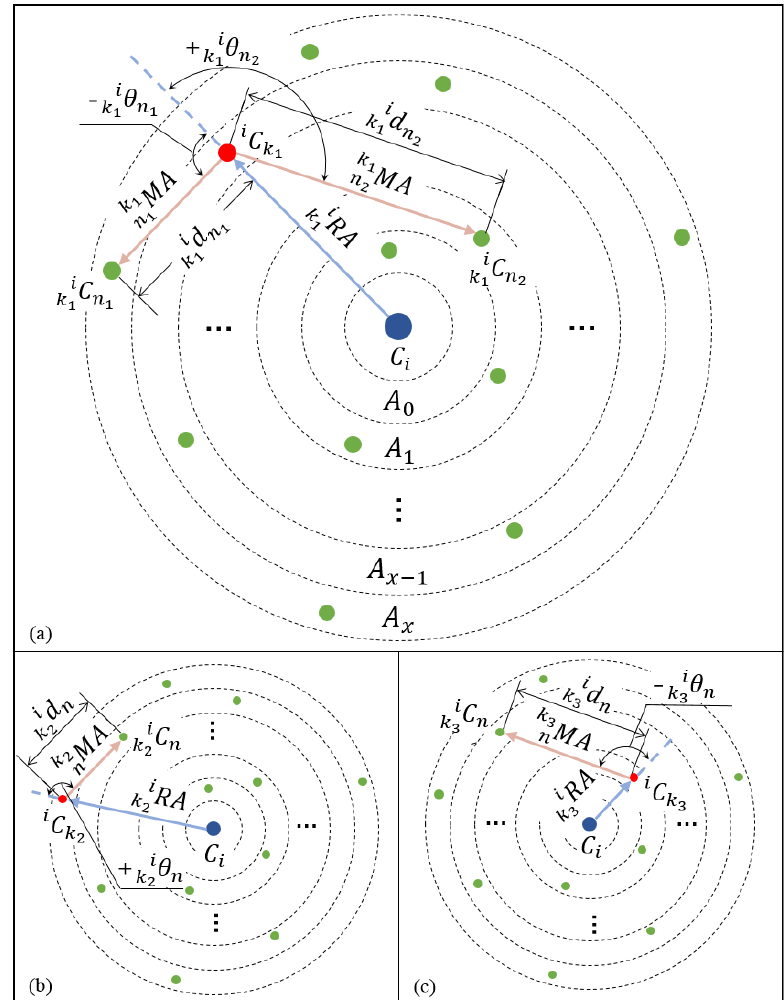
Figure 4. Process of constructing subdescriptors of C i . ( a – c ) Illustrations of different neighboring clusters of C i